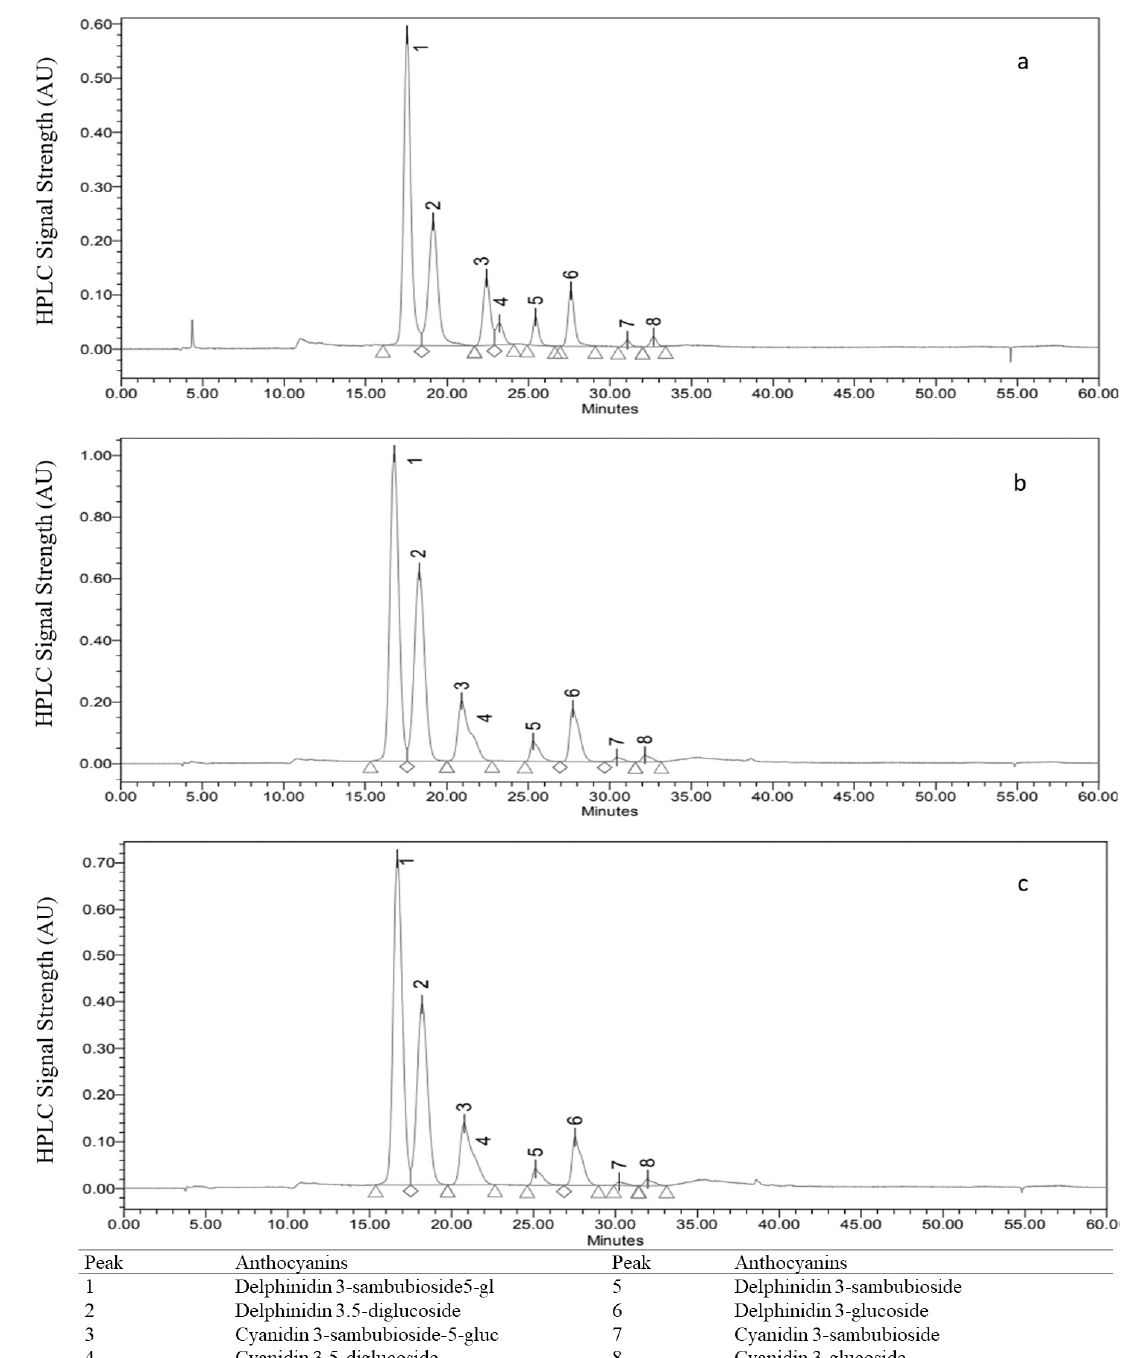
Figure 3. High performance liquid chromatography (HPLC) identification of anthocyanins at 520 nm in the cryoconcentrate (C) ( a ) and concentrates by evaporation at 70 ◦ C (R70) ( b ) and at 80 ◦ C (R80) ( c